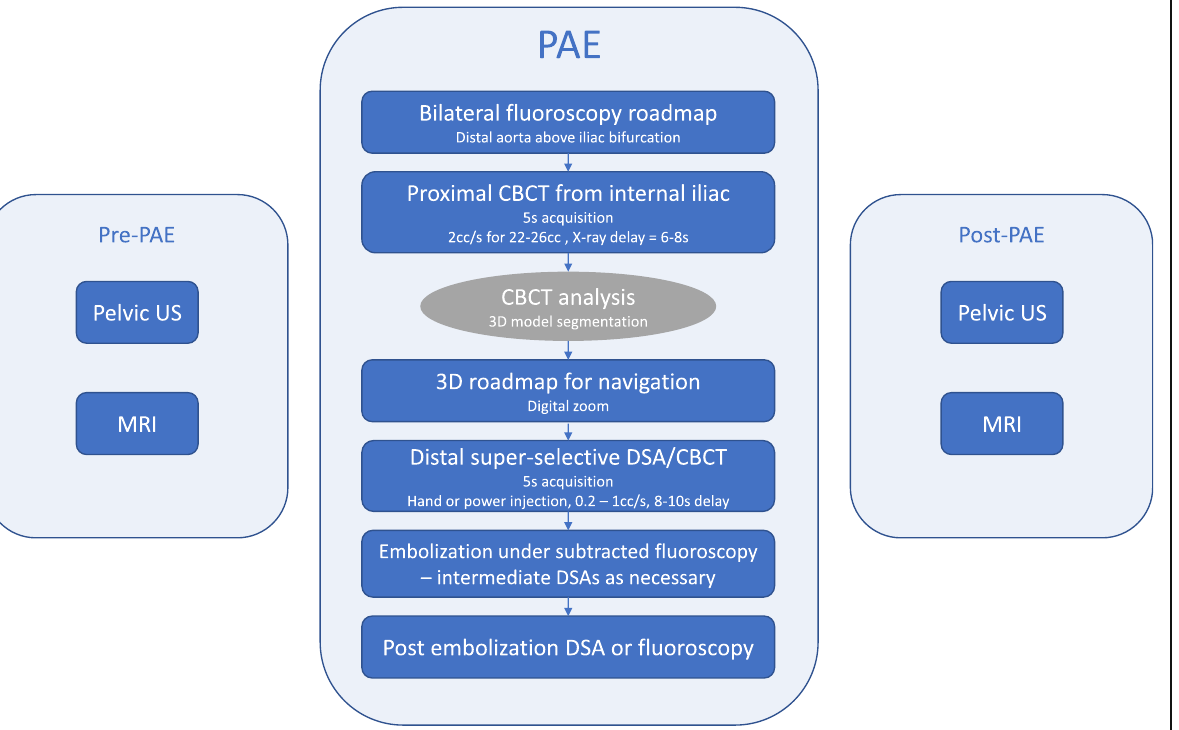
Fig. 1 Imaging workflow summary. Detailed steps of the proposed pre, post and intraprocedural PAE imaging workflow for each side, from planning to guidance and